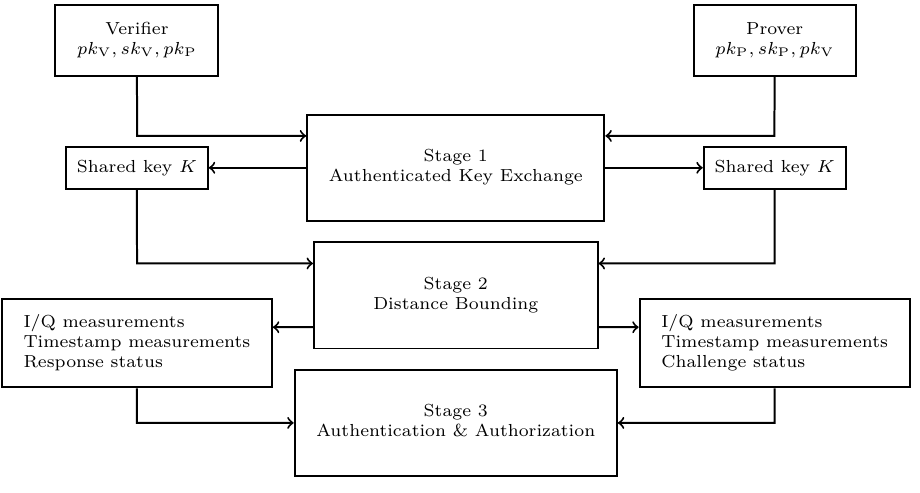
Figure 2: A high level overview of the SDB protocol proposed in this